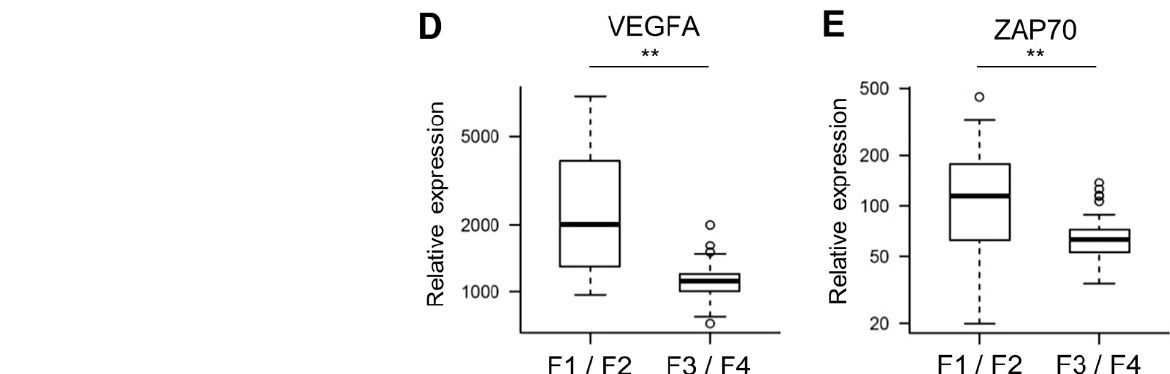
Figure 3. Expression of each gene comprising the gene signature in early stage versus late-stage liver fibrosis. Relative expressions of 5 genes in 24 patients with early-stage fibrosis and in 53 patients with late-stage fibrosis. * p < 0.05; ** p < 0.01. ( A ) CHIT1. ( B ) FCER1G. ( C ) OSM. ( D ) VEGFA. ( E ) ZAP70.